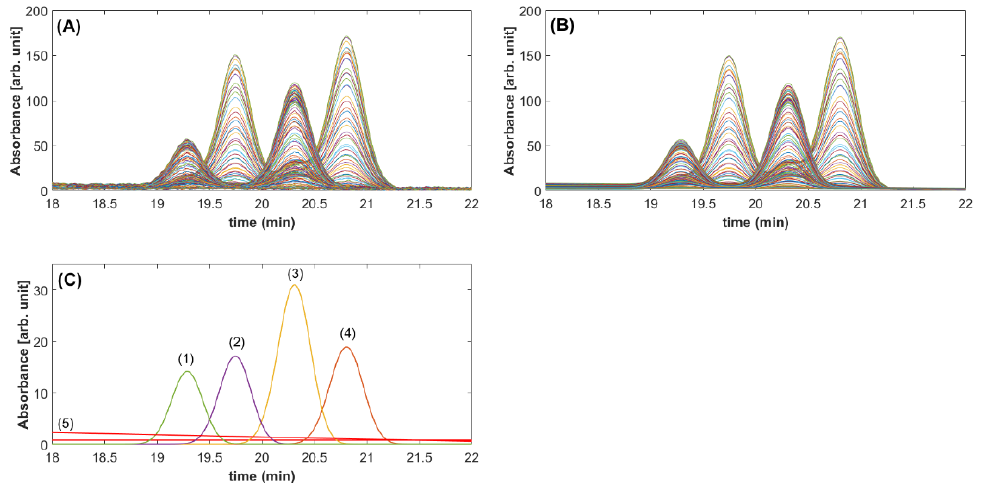
Figure 6. ( A ) experimental data, ( B ) fitted data and ( C ) model peaks obtained with itMPF. All diterpene esters were injected at 5 mg/mL. (1) Kahweol oleate, (2) cafestol oleate, (3) kahweol palmitate, (4) cafestol palmitate and (5) additional peak to better describe the baseline drift.